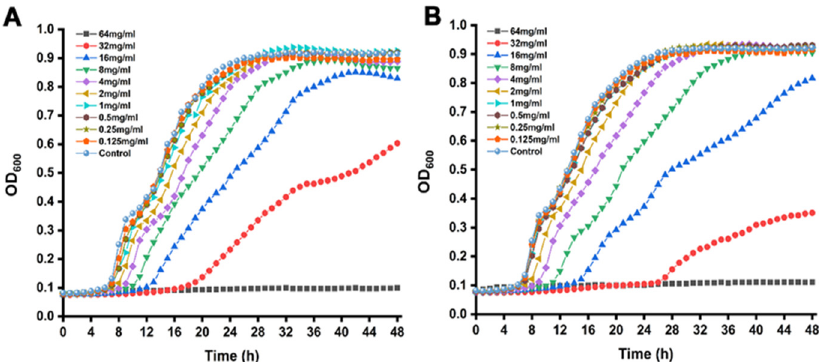
Figure 1. Growth curve of S. Typhimurium SL1344 in the presence of ( A ) propionate and ( B ) butyrate.